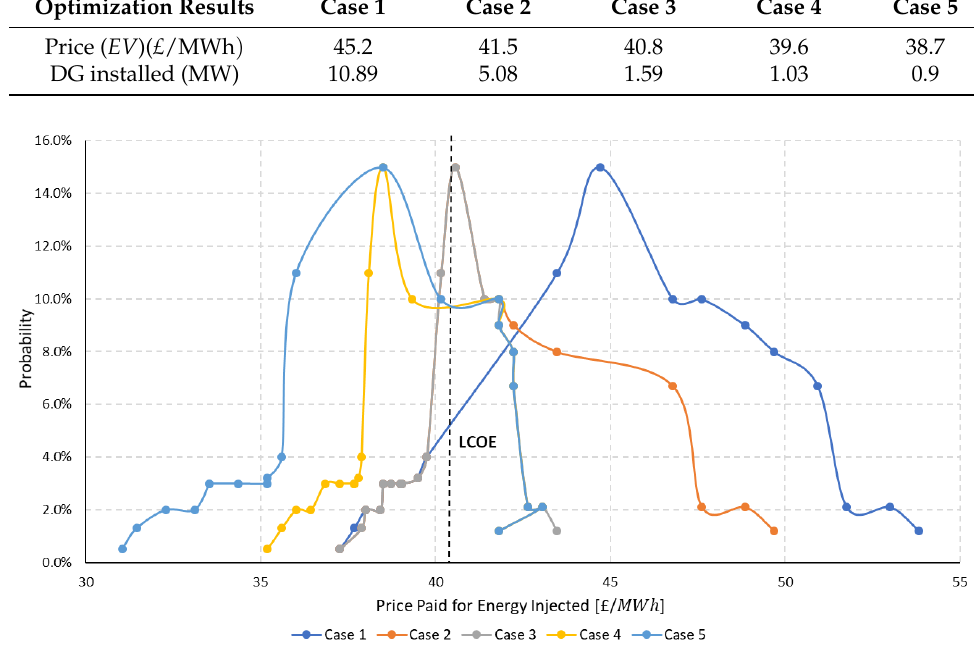
Figure 4. Probability distribution of study cases.